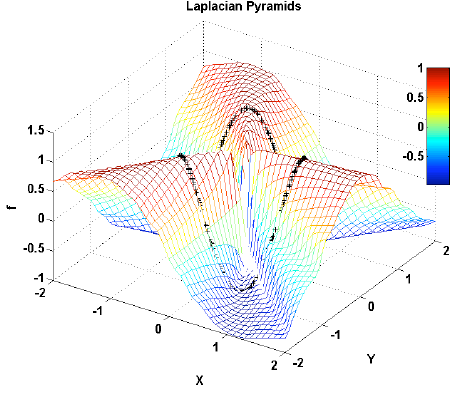
Figure 6. The function f = cos(3 ϑ ) , with ϑ = arctan( Y/X ) , is extended to the plane ( X, Y ) by Laplacian Pyramids (with the finest level l = 10 and σ , ..., y } , is given by M = 350 points randomly selected on the unit sample set, { y 1 M circle black